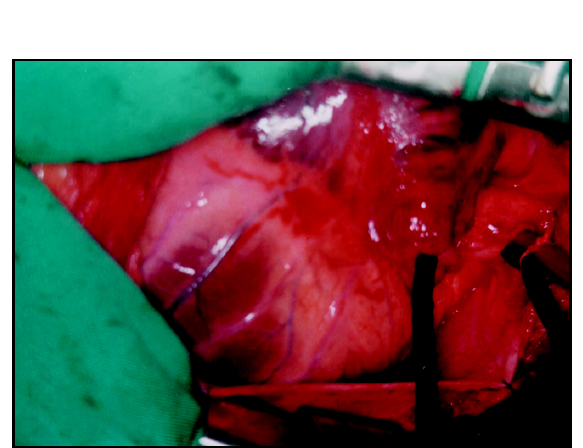
Fig. 3 - Realizada sutura da fenda utilizando-se duas tiras de pericárdio bovino.